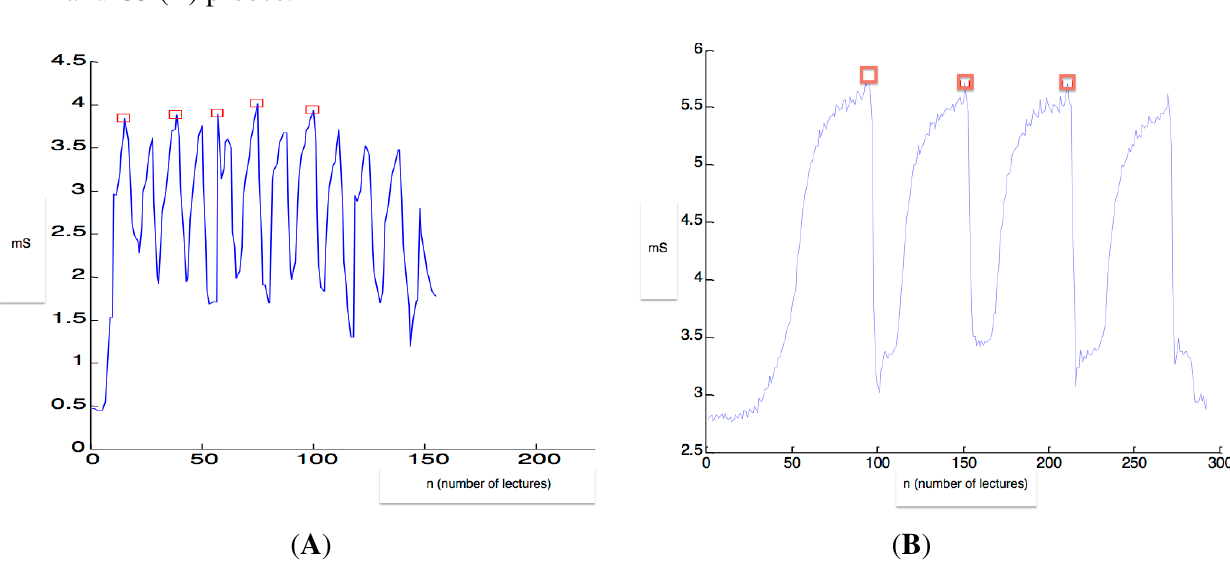
Figure 11. Explanation of the selection of the local maxima with Matlab (cid:114) for the C1 ( A ) and C3 ( B )